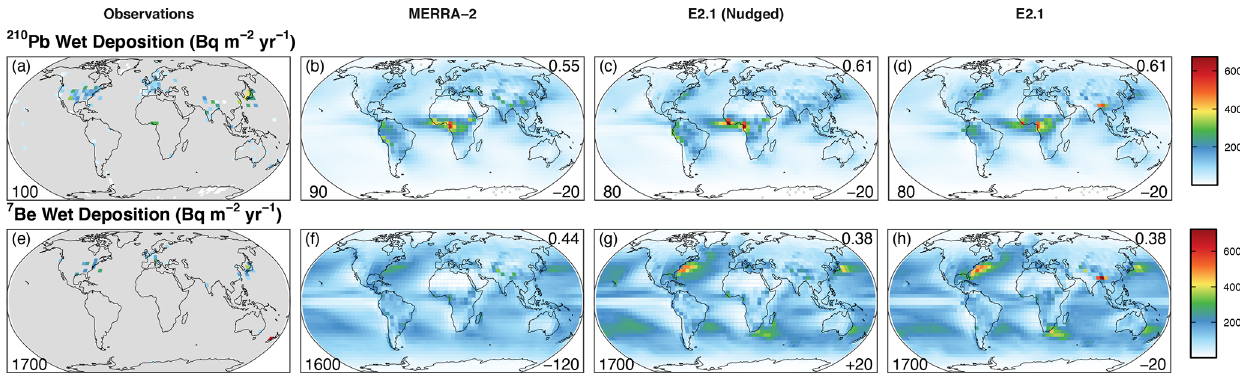
Figure 14. Radionuclide wet deposition fluxes. Annual average wet deposition flux in mBqm − 2 s − 1 for 210 Pb (top row) and 7 Be (bottom row). The left column shows observed values aggregated to the model resolution for 210 Pb and 7 Be. The three columns on the right show (from left to right) values simulated by GEOS-Chem driven by meteorology archived for 2005–2014CE from MERRA-2, E2.1 nudged to MERRA-2, and free-running E2.1. The number in each panel’s lower left shows the mean value of the observations or models sampled at the observed locations. The top right number shows the pattern correlation ( R ) of the simulated values with the respective observations. The lower right number shows the mean bias of the simulated values with respect to the